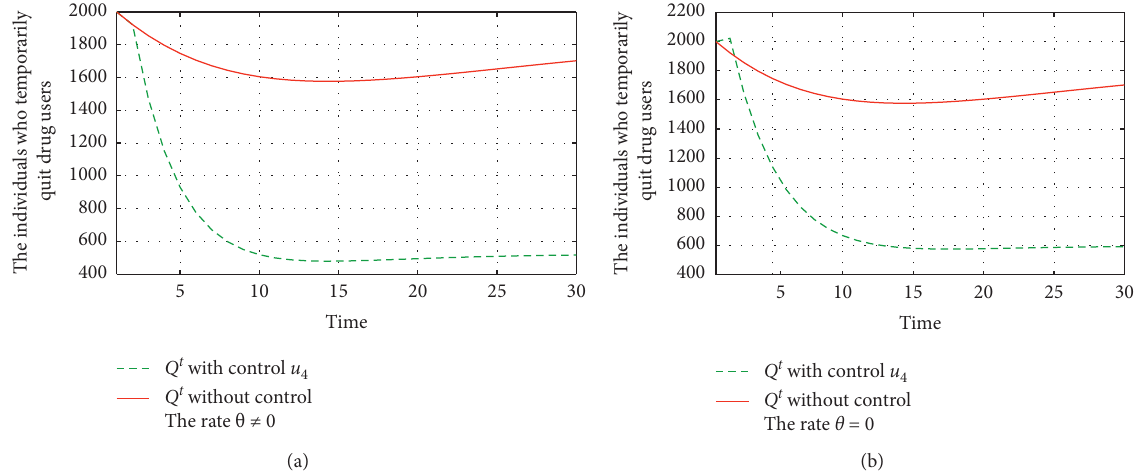
Figure 5: (a) The evolution of the Q t with and without controls with θ ≠ 0. (b) The evolution of the Q t with and without controls with θ � 0.